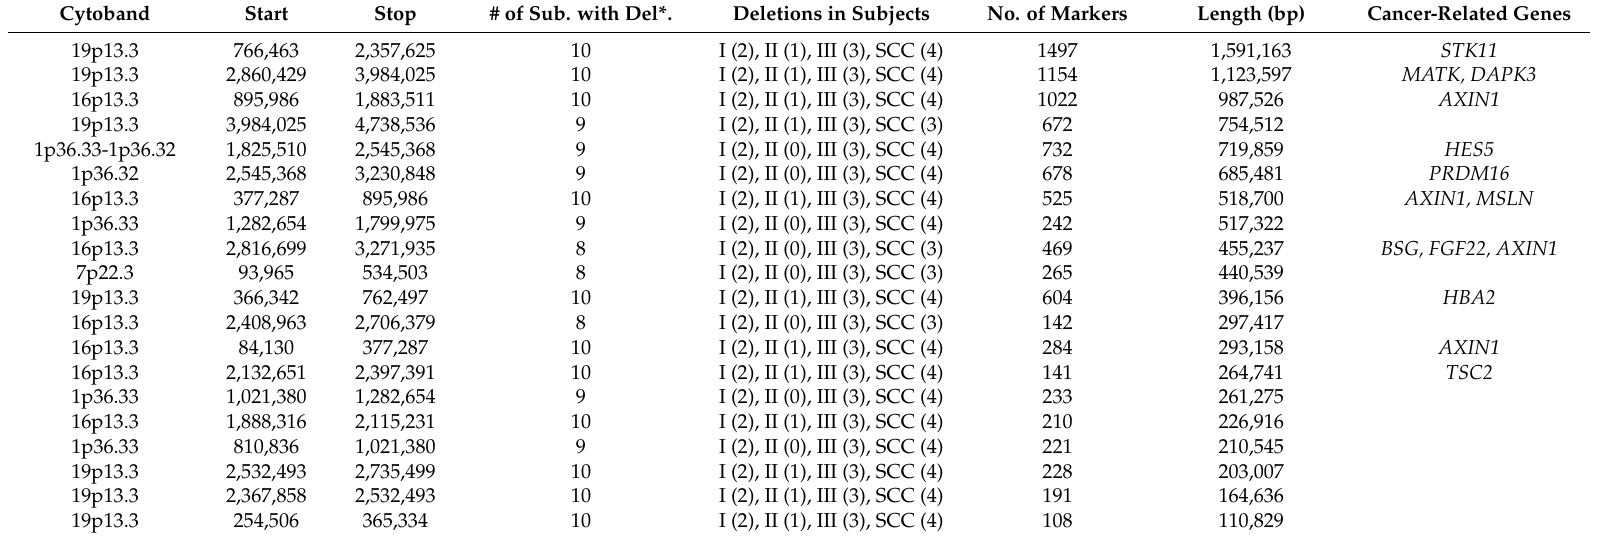
Table 3. Top 20 CNA chromosome regions with recurrent somatic CNAs (deletions >100 kb) in the cases; not observed in the reference group.